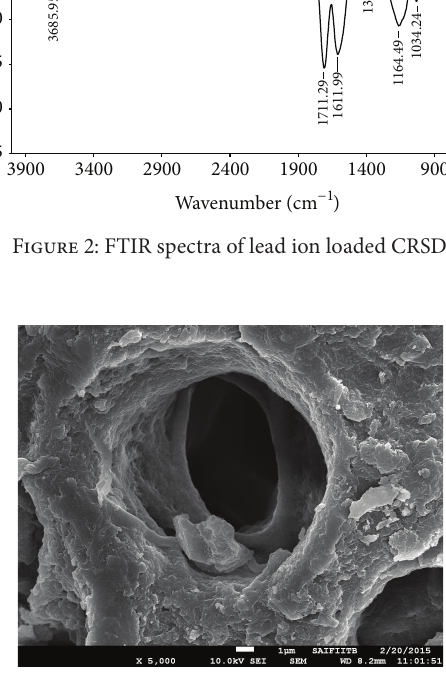
Figure 3: SEM image of CRSD.